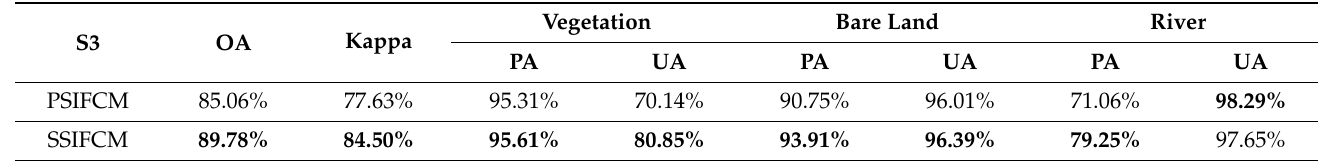
Table 3. Evaluation of S3 image pixel-level and object-level spatial intuitive fuzzy clustering algo- rithms classification results.